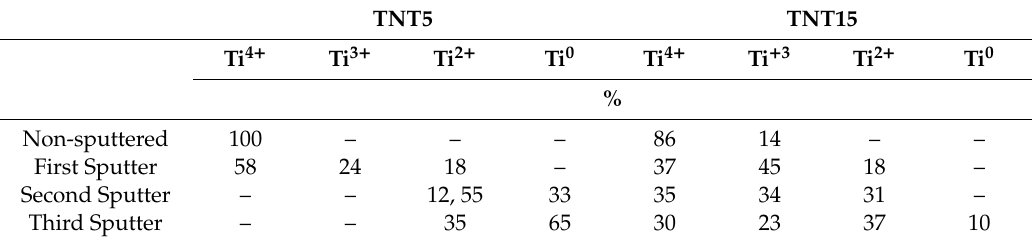
Table 2. XPS depth profile of TNT5 and